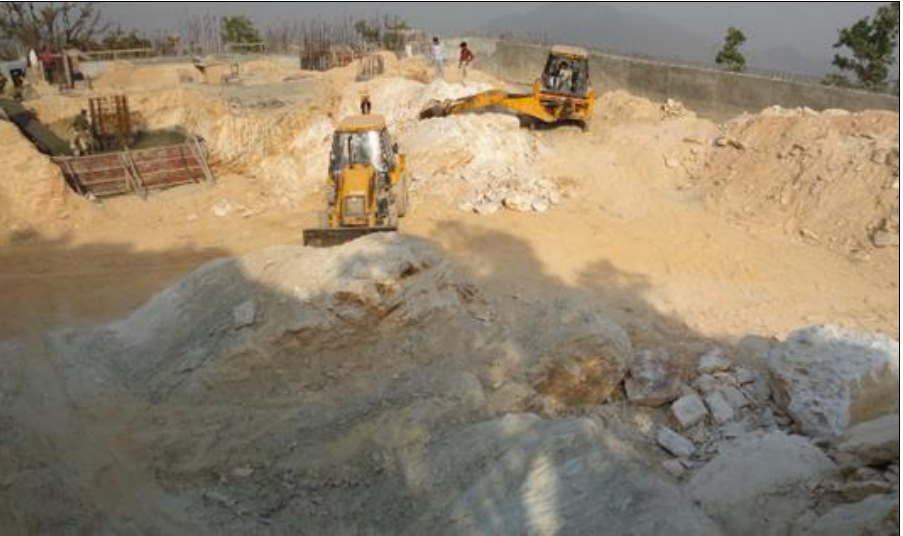
Figure 3. Preparation of site using machinery